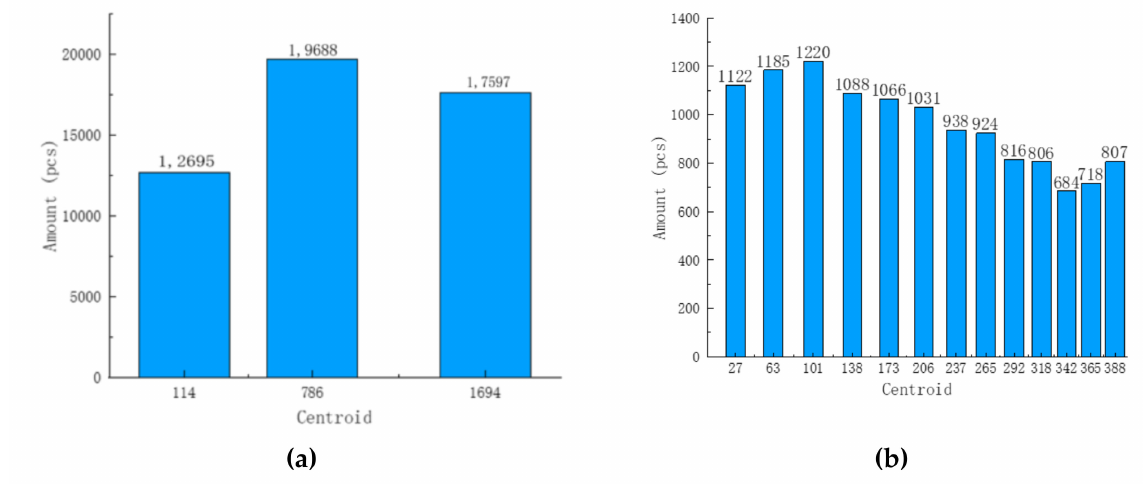
Figure 9. Concurrent simulation. ( a ) First clustering result graph; ( b ) Second clustering results graph.